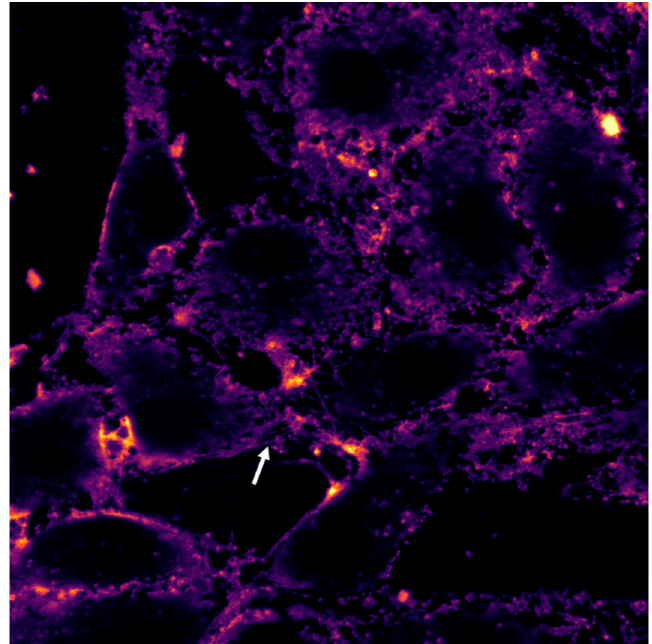
Figure 12 . Image of a portion of Vero culture cells stained with the complex 10a by using the channel mode, with artificial colors. The white arrow marks the filopodia of the cell.